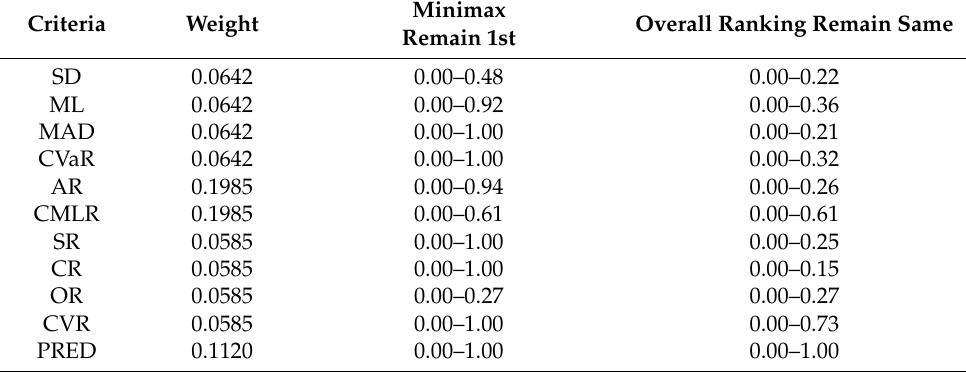
Table 4. Stability intervals.